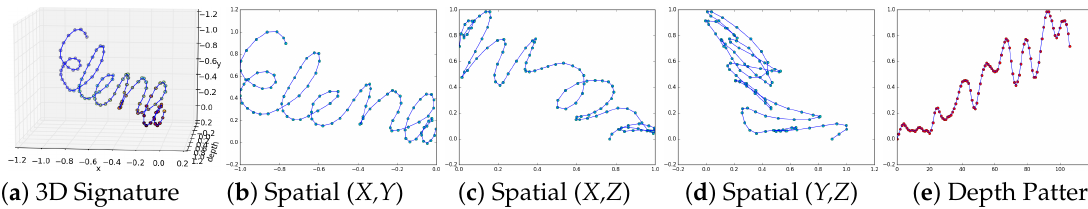
Figure 6. Illustration of different features which are used for in-air signature verification. We fully exploited different combinations of the features inherently present in the in-air signature trajectory to improve the performance of the verification system. The unique depth feature of a user especially plays a vital role in verification